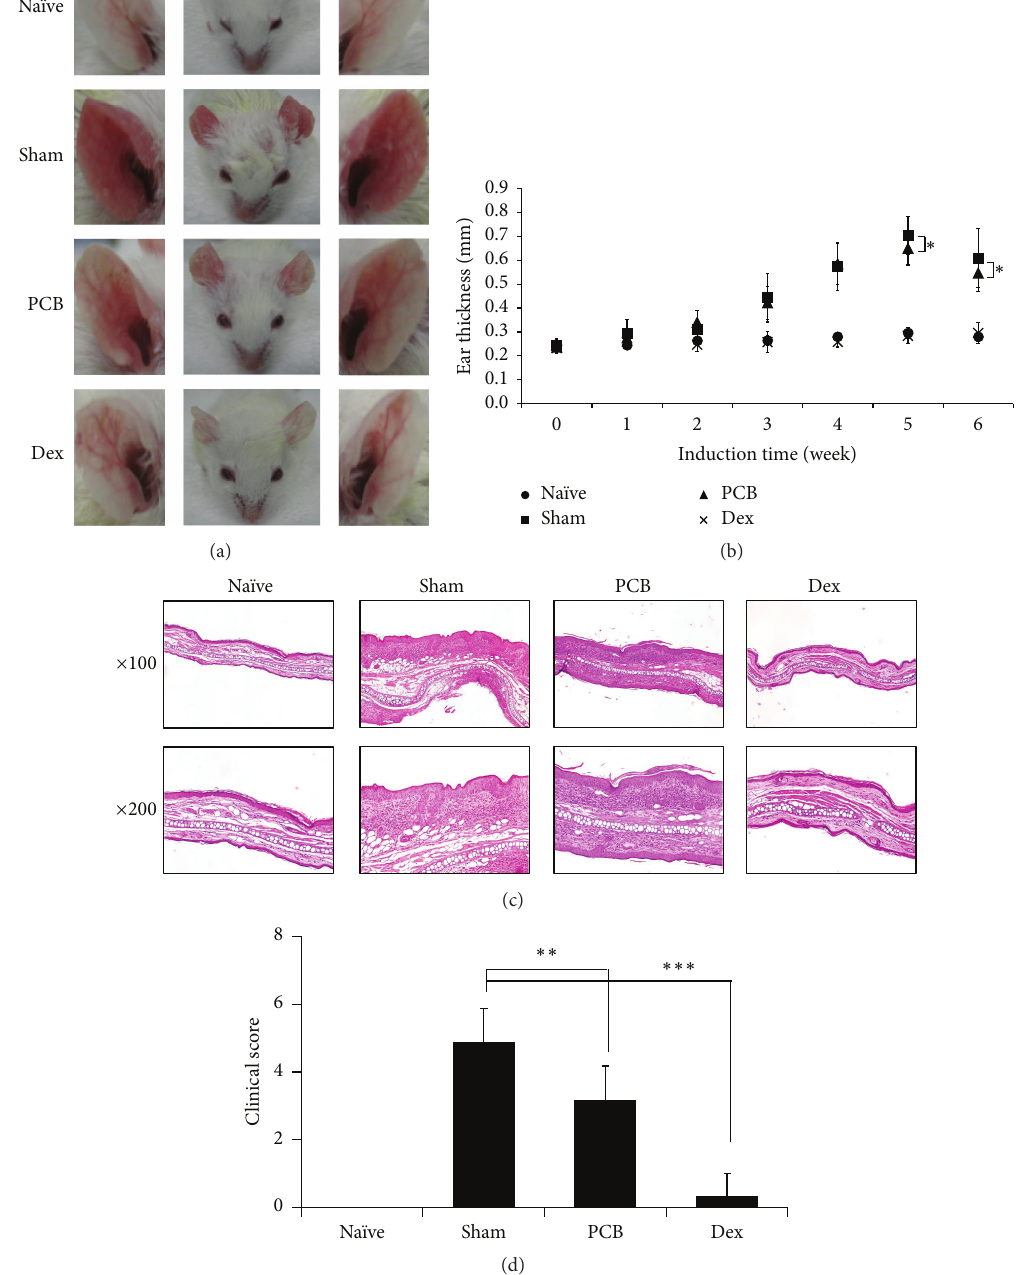
Figure 2: PCB extract alleviates the symptoms of DNCB/HDM-induced-atopic dermatitis. (a) Typical photographs of ear lesions developed by the treatments of DNCB and HDM on day 62. (b) Ear thickness was measured using digital thickness gauge on next day after HDM treatment from first challenge to sixth. (c) Ear lesions isolated from mice were fixed with 10% formalin solution and embedded in paraffin. To evaluate epidermal thickness and infiltrated inflammatory cells, H&E staining was performed and observed using a microscope at 100x and 200x magnification. (d) Clinical score was determined by criteria such as erythema/edema, scaling/dryness, and excoriation/hemorrhage to evaluate degree of severity in each ear lesion on day 62. Data are presented as the mean ± standard deviation (SD) of triplicate determinations and were analyzed using unpaired 𝑡 -test. ∗ 𝑃 < 0.05 , ∗∗ 𝑃 < 0.01 , and ∗∗∗ 𝑃 < 0.001 versus sham